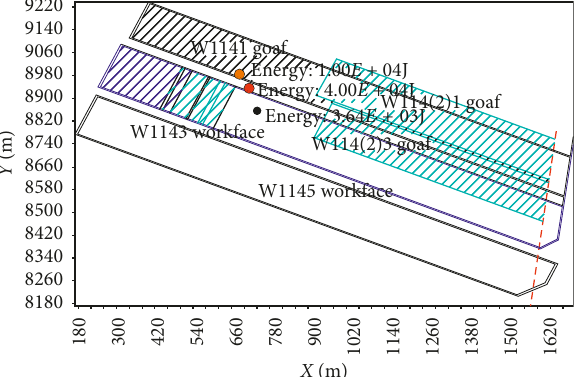
Figure 14: Roof breaking positioned by microseismic.